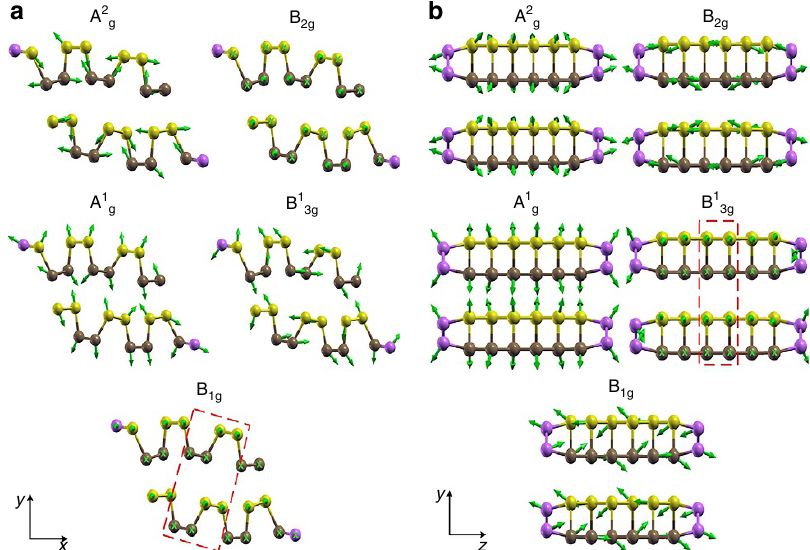
Figure 3 | Atomic displacements corresponding to the observed Raman active modes at the edges. ( a ) Zigzag edge; ( b ) armchair edge. The atoms at the edges of each slab are shown in